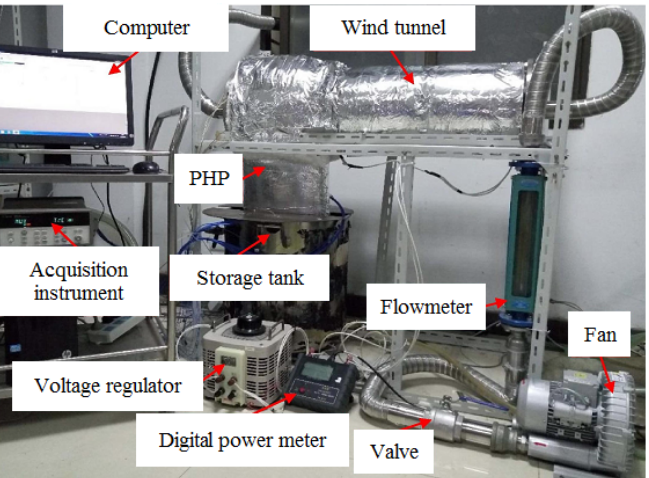
Figure 4. AGPHP heat recovery experiment [59]. Deng et al. (2017).